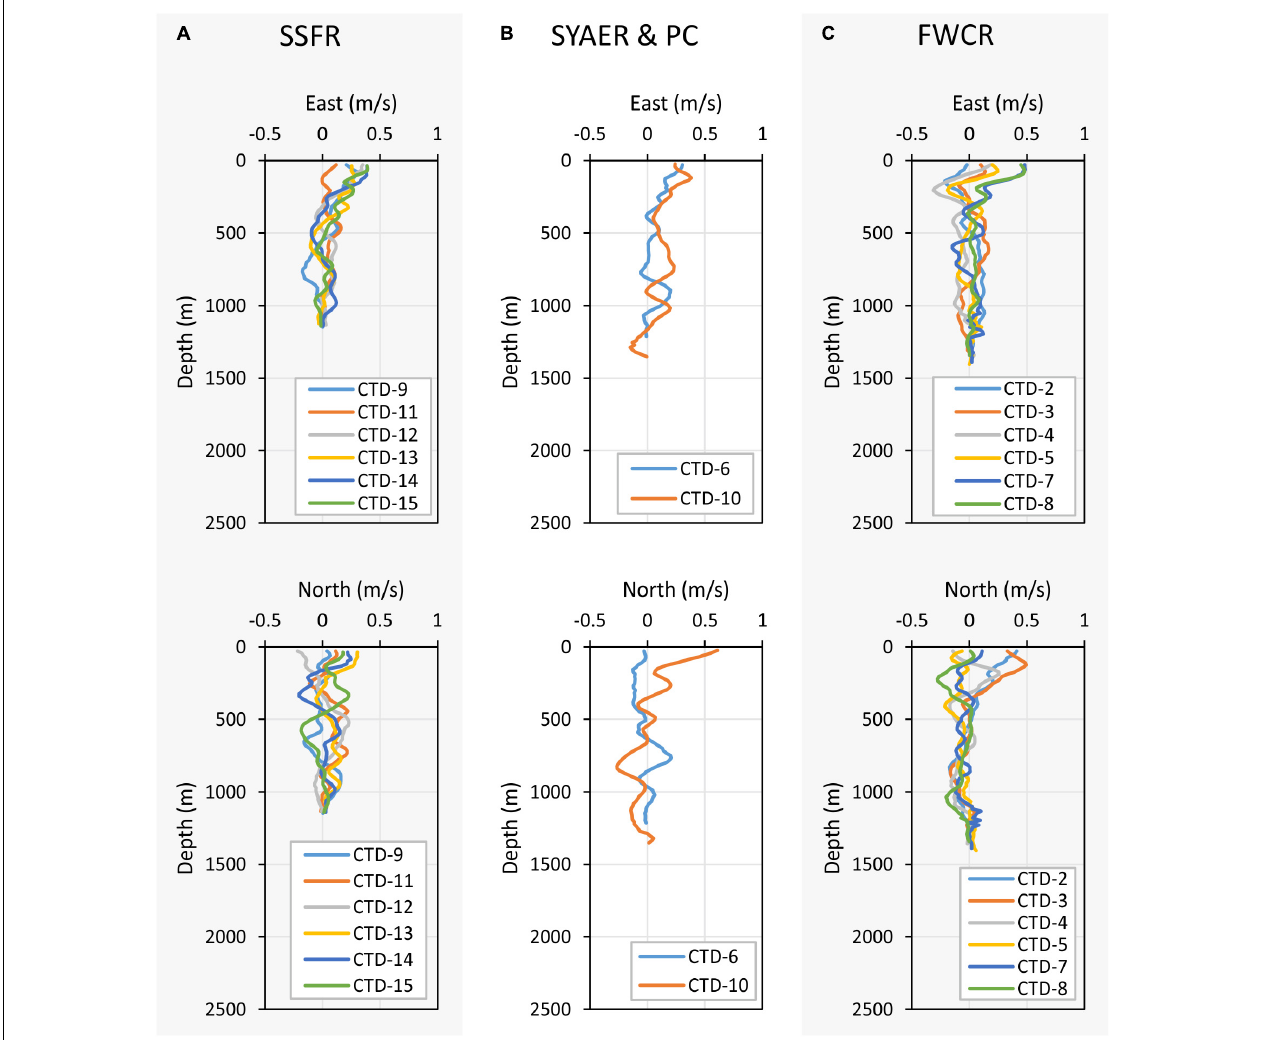
FIGURE 8 | Depth profiles of the east (upper three graphs) and north velocities (lower three graphs). (A) Shows the east and north velocity of stations at SSFR – Southern Summit Formosa Ridge, (B) displays station data of SYAER – South Yun An East Ridge (CTD-6) and PC – Penghu Canyon (CTD-10), and (C) shows data recorded above FWCR – Four Way Closure